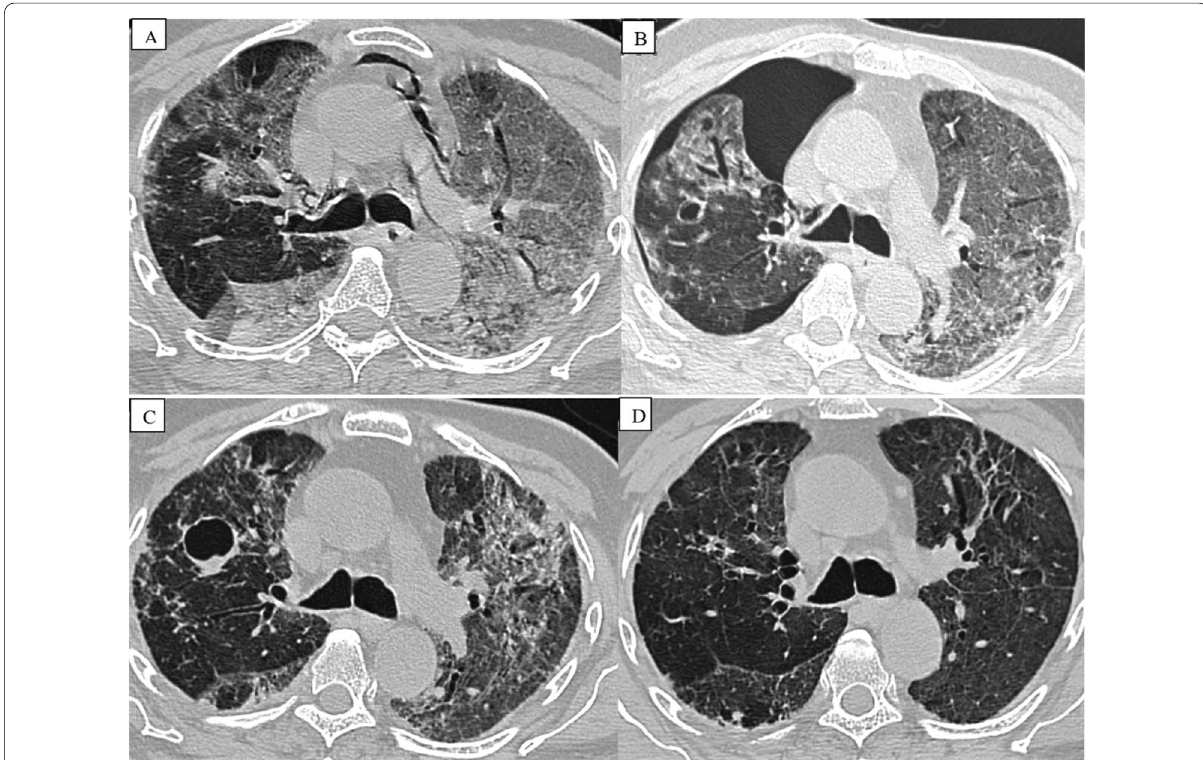
Fig. 3 A 62-year-old COVID-positive man with acute dyspnea and cough was brought to the hospital. The patient was suffering from acute ARDS. He was admitted to the intensive care unit and placed on mechanical ventilation. The first HRCT scan A indicated significant consolidation and ground glass opacities in both lungs with pneumomediastinum. He developed pneumothorax on repeat CT B after 7 days of mechanical ventilation. The patient’s clinical state improved over time, and a 20-day CT scan C revealed complete resolution of the pneumothorax and pneumomediastinum, but a new cavity had developed in the anterior portion of the right lung. Patient followed up after 3 months D revealed complete resolution of cavity with mild residual fibrosis in both lungs